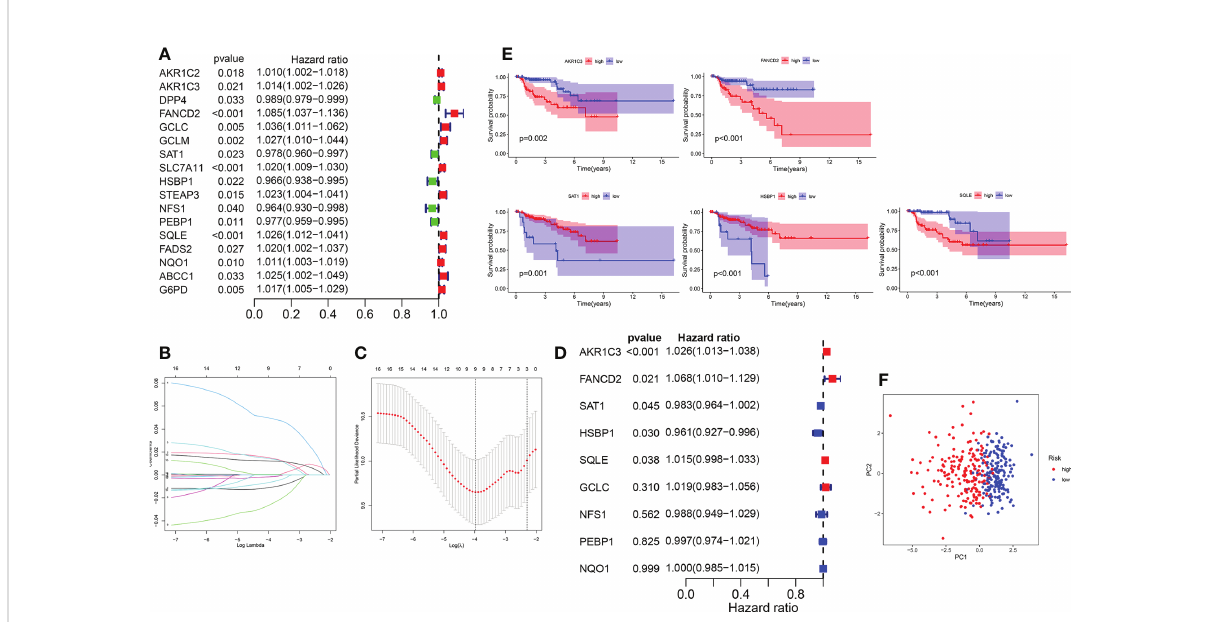
FIGURE 3 Construction of the FRGPI in training cohort. (A) A total of 17 prognostic related FRGs were analyzed using univariate Cox analysis. (B) LASSO coef fi cient pro fi les of the FRGs associated with survival of KIRP. (C) Plots of the cross-validation error rates. (D) A total of 5 independence prognostic genes were identi fi ed using multivariate Cox analysis. (E) Five genes were identi fi ed to be signi fi cantly associated with survival based on multivariate Cox analysis. (F) Principal coordinate analysis plot based on the risk score. p< 0.05 was considered statistically signi fi